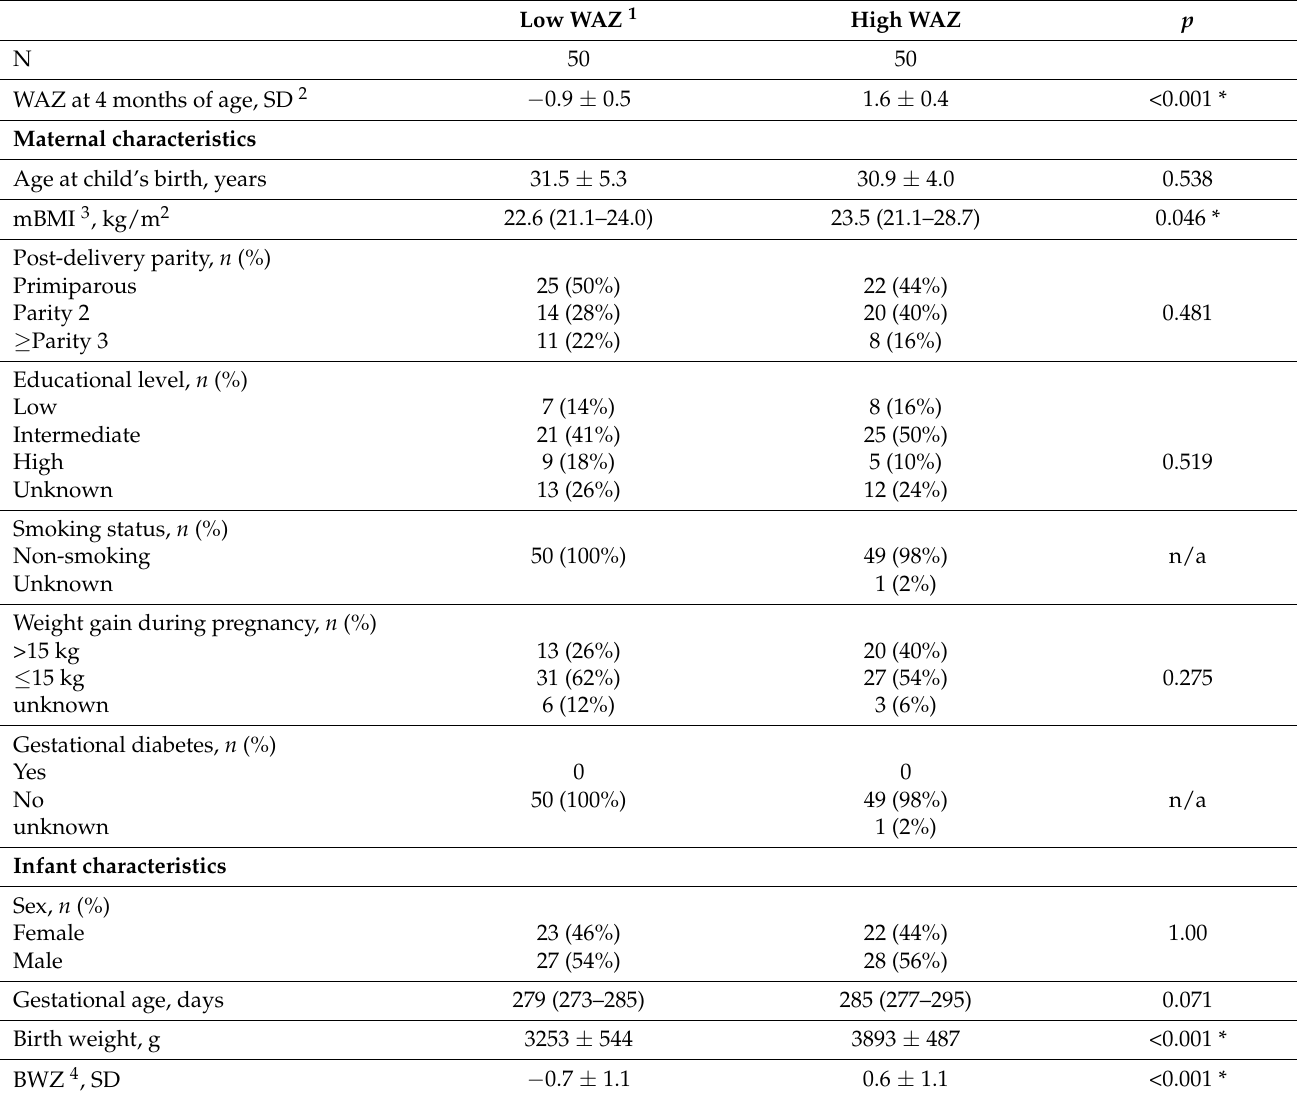
Table 1. Characteristics of mothers and infants in the low and high weight-for-age Z-score (WAZ) groups. Low WAZ 1 High